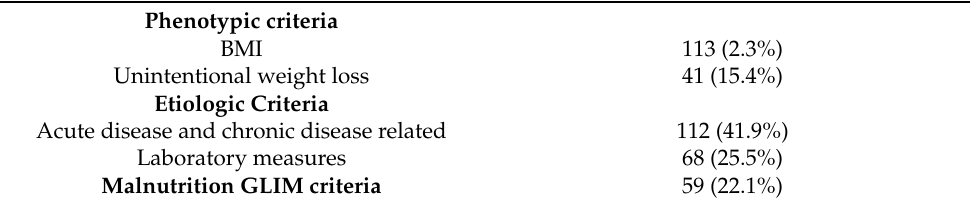
Table 3. Nutritional assessment: malnutrition according to single indicators and according to GLIM criteria absolute and relative frequencies